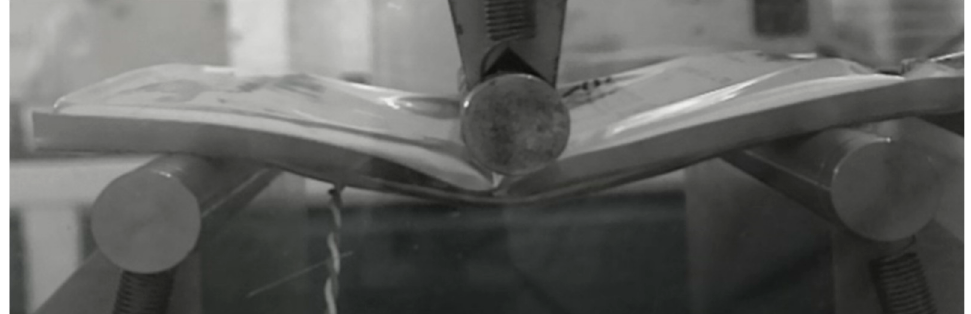
Figure 2. 3PB test of Dow Kokam 50106100 cell showing buckling of the